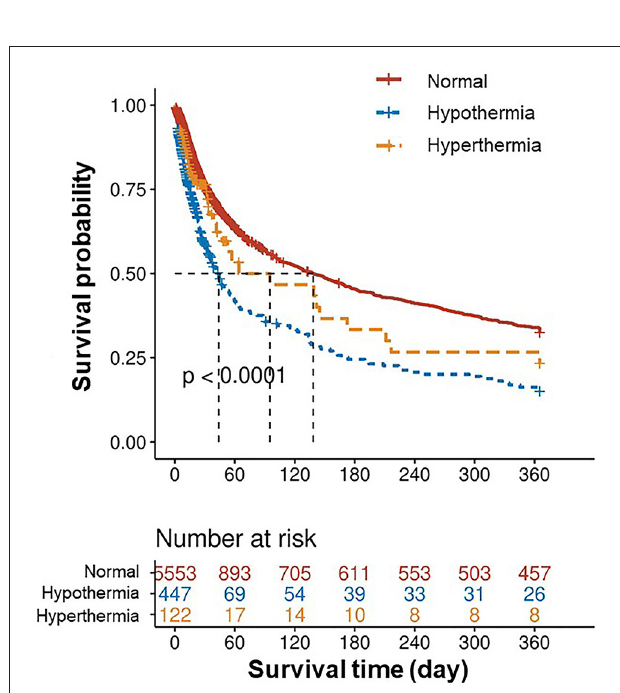
FIGURE 3 | Kaplan-Meier curves of 1-year mortality by temperature